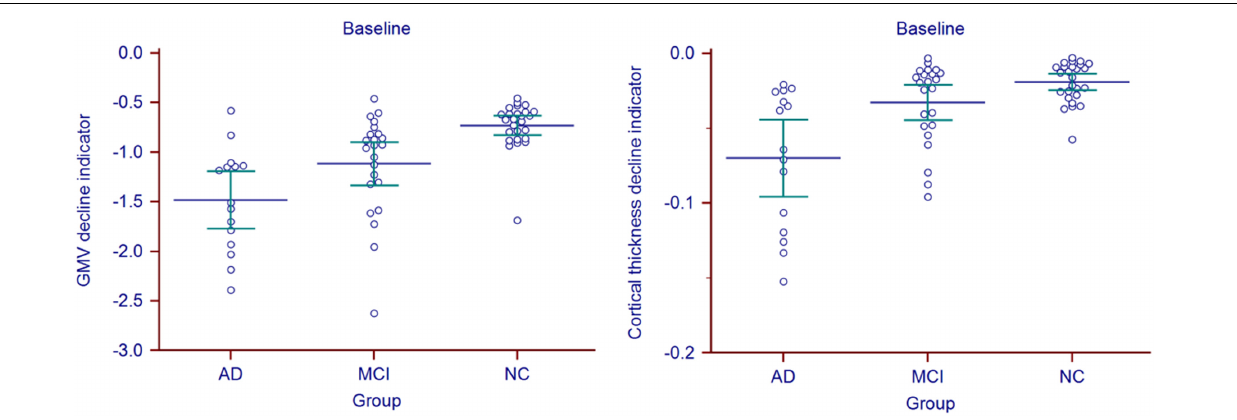
FIGURE 2 | Baseline atrophy indicators for all the individuals in AD, MCI, and NC group.